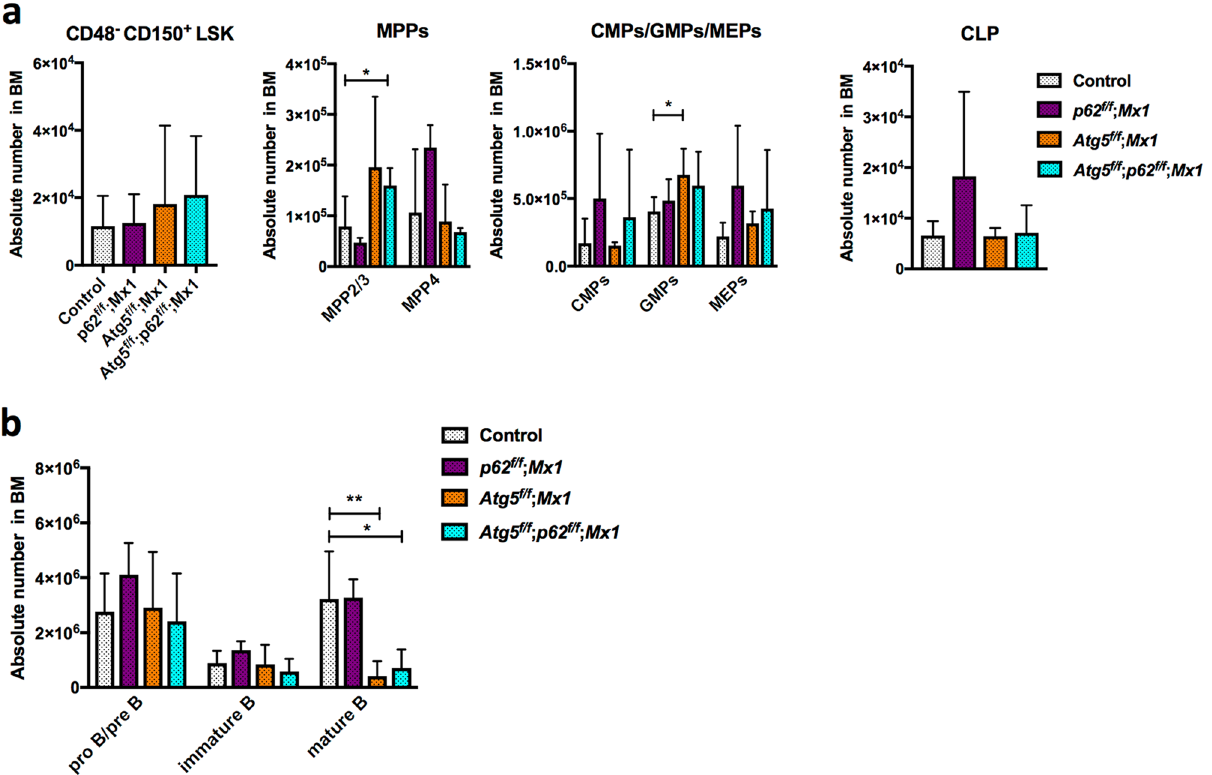
Figure 7. Comparative analysis of HSCs, progenitors, and B cells in BM from control, p62 f / f ; Mx1 , Atg5 f / f ; Mx1 , and Atg5 f / f ; p62 f / f ; Mx1 mice. ( a ) Absolute numbers of CD48 − CD150 + LSK cells, multipotent progenitors (MPPs; MPP2/3 and MPP4), common myeloid progenitors (CMPs), granulocyte macrophage progenitors (GMPs), megakaryocyte erythrocyte progenitors (MEPs), and common lymphoid progenitors (CLPs) in BM. Data are the mean ± SD (n = 4–7). ( b ) Absolute numbers of mature B (CD43 − B220 hi IgM + ), immature B (CD43 − B220 lo IgM + ), and pro B/pre B (CD43 − B220 lo IgM − ) cells in BM. Data are the mean ± SD (n =